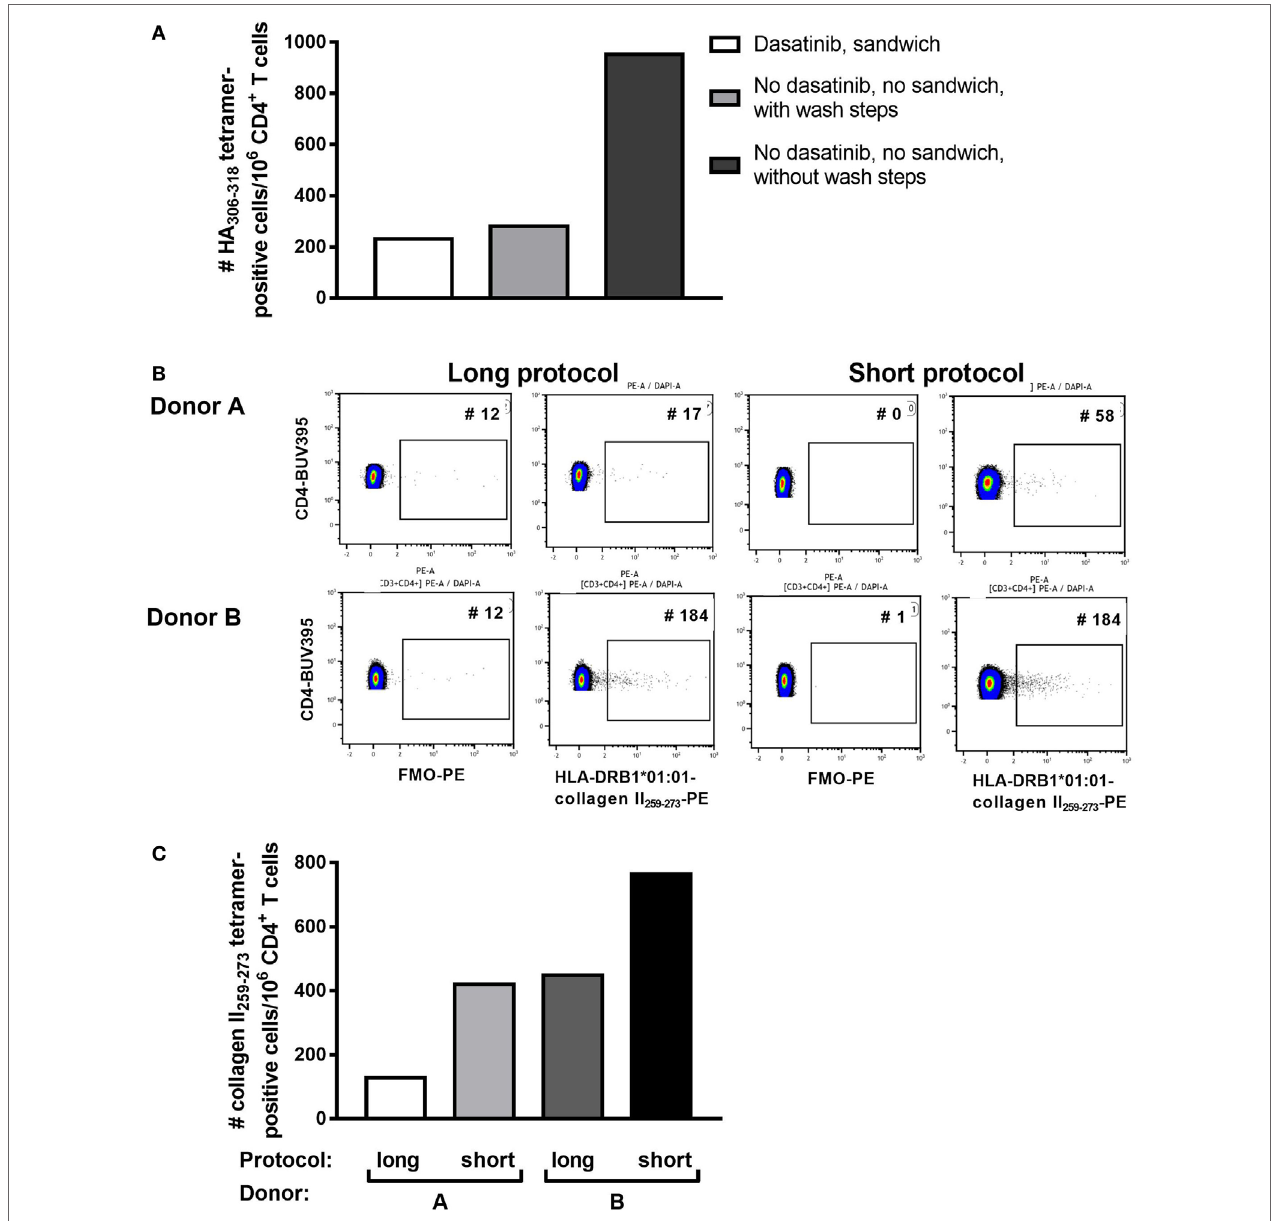
FIgURe 1 | Shorter staining protocol resulted in higher numbers of tetramer-positive CD4 + T cells. Three staining protocols were compared as indicated. (A) The number of HLA-DRB1*0101 HA 306–318 -positive CD4 + T cells per million CD4 + T cells is depicted for the three protocols in peripheral blood mononuclear cells of one representative individual. (b) Flow cytometry plots for two patients stained with HLA-DRB1*0101-collagen II 259–273 , using either the short or the long protocol. The negative control FMO plots are shown. (C) The number of HLA-DRB1*0101-collagen II 259–273 + CD4 + T cells per million CD4 + T cells using the short versus the long staining protocol in Donors A and B, as depicted in panel (b)